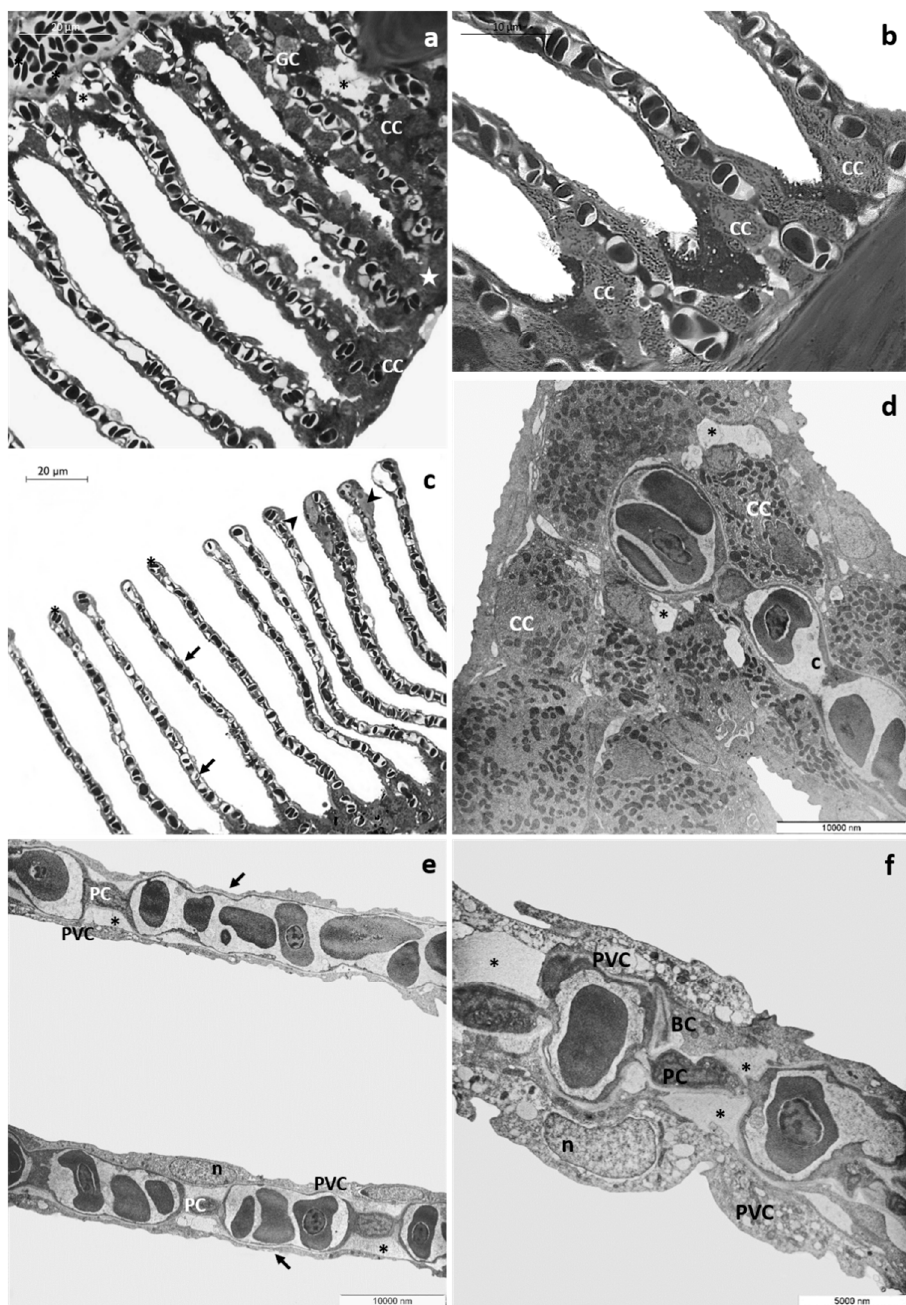
Figure 3. Representative micrographs of T. pavo gills after 48 h of exposure to 8 µg/L of CPF. ( a ) Light micrograph showing the proliferation of primary epithelium (star). The detachment of the primary epithelium from the underlying connective tissue (asterisks) could also be observed. Note the ectopia of chloride cells (CC) and goblet cell (GC). ( b ) Detail of chloride cells (CC) in the lamellar proximal portion. ( c ) Immigrated chloride cells are observed in the apical end of secondary lamellae (black arrowed). Note the thinning of the secondary epithelium (black arrows) and the aneurysms in the lamellar apical tips (asterisks). ( d ) TEM micrograph showing wide intercellular spaces in the main filament (asterisks). Note the reduced and disorganized tubular vesicle system of chloride cells (CC). ( e ) The typical ultrastructural organization of secondary lamellae is completely lost and the thinning of epithelial layers is visible (black arrows). Note the degeneration of pavement cells (PVC) and the appearance of large lacunae (asterisks); n= nucleus, PC= pillar cell. ( f ) Cellular debris, apoptotic bodies, and degenerated nuclei are evident in pavement cells (PVC) and basal cells (BC). Note the secondary epithelium’s detachment from the below basal lamina (asterisks); PC= pillar cell, n= nucleus.